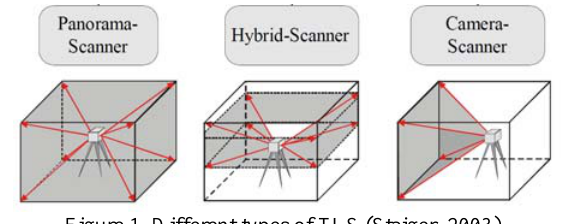
Figure 1. Different types of TLS (Staiger,